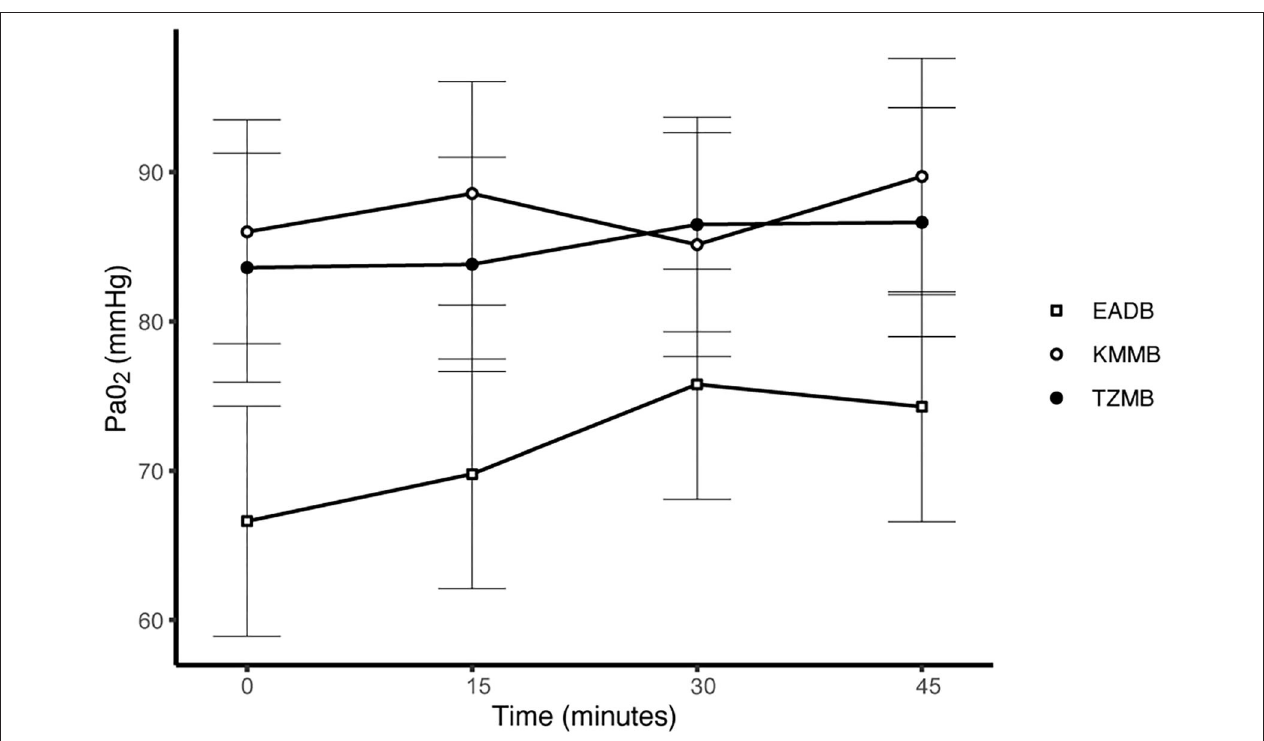
FIGURE 4 | Illustration of partial arterial pressure of oxygen (PaO 2 ) over time. Values of each timepoint are the means for treatment group 1 (KMMB), treatment group 2 (TZMB) and the control group (EADB) ± standard error (error